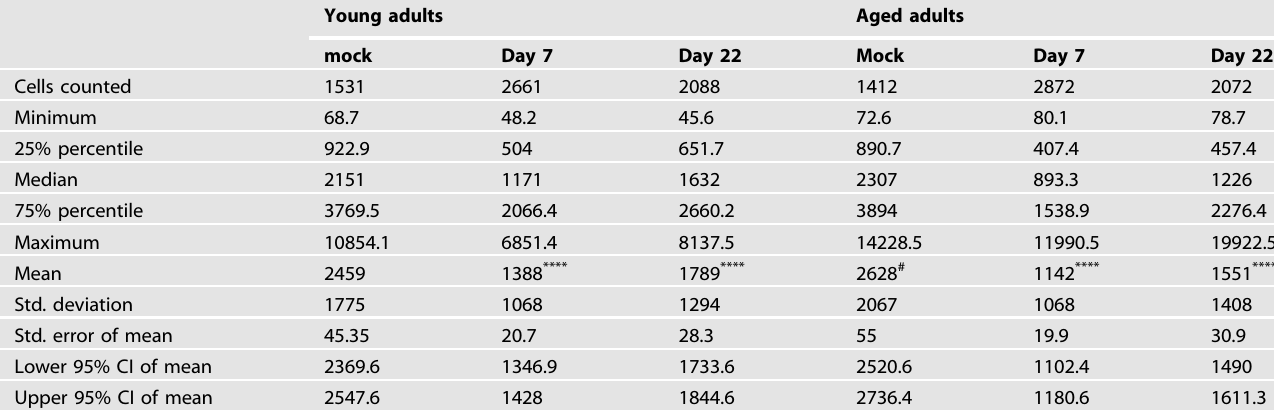
Table 2. Adipocyte size frequency distribution in